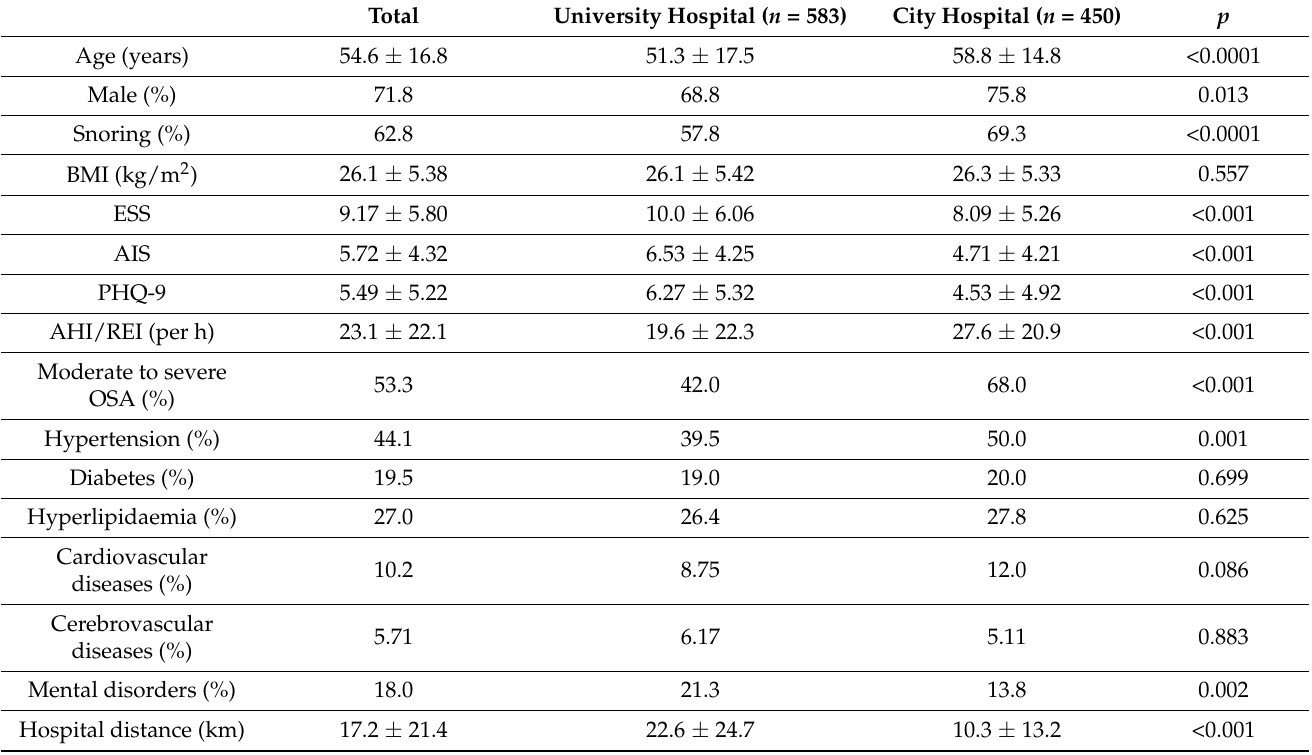
Table 1. Characteristics of patients included in the study ( n =